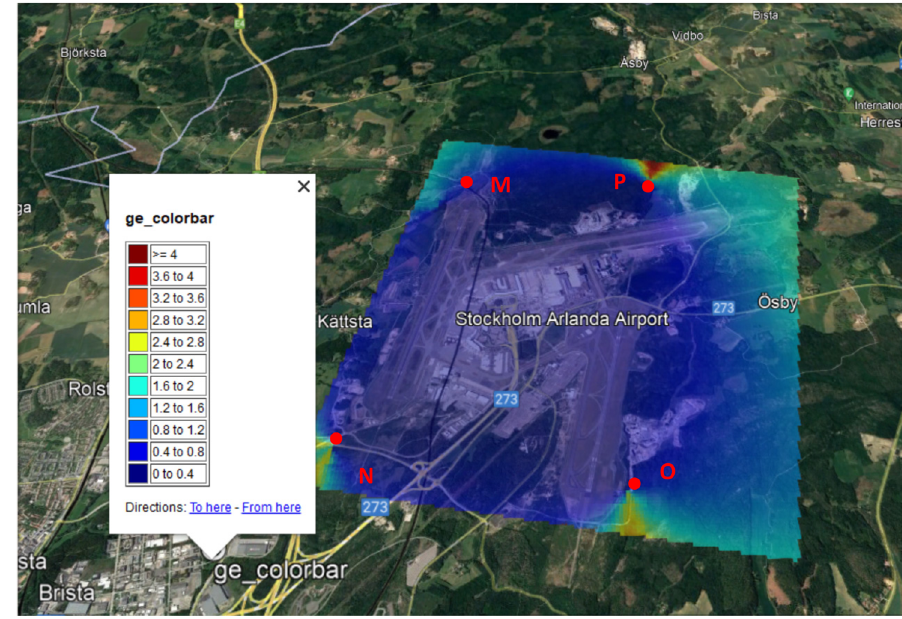
Figure 4: DOP of optimised wireless security network with search area constraints over Arlanda international airport.